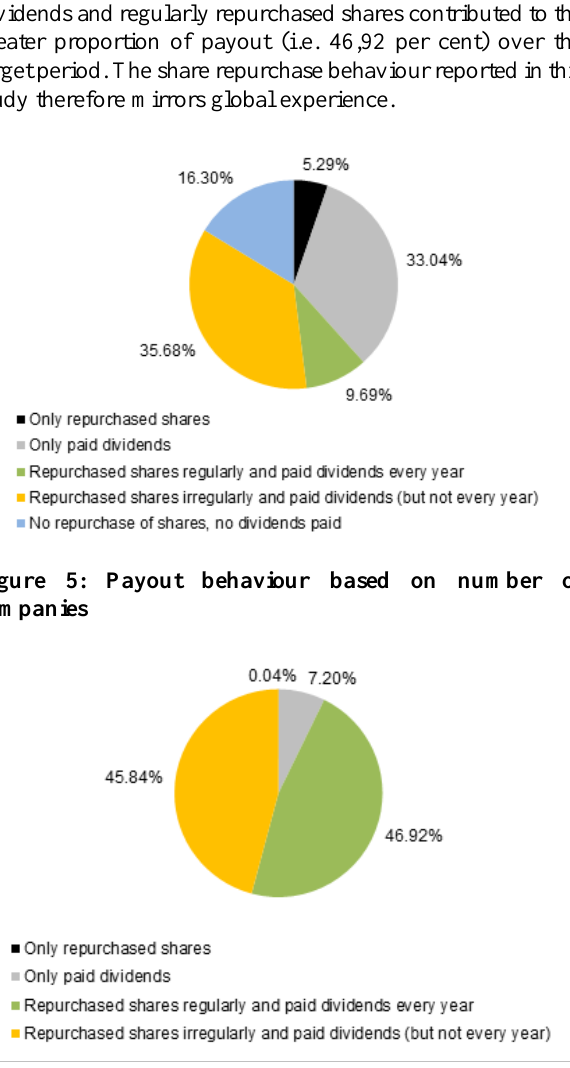
Figure 6: Payout behaviour based on value